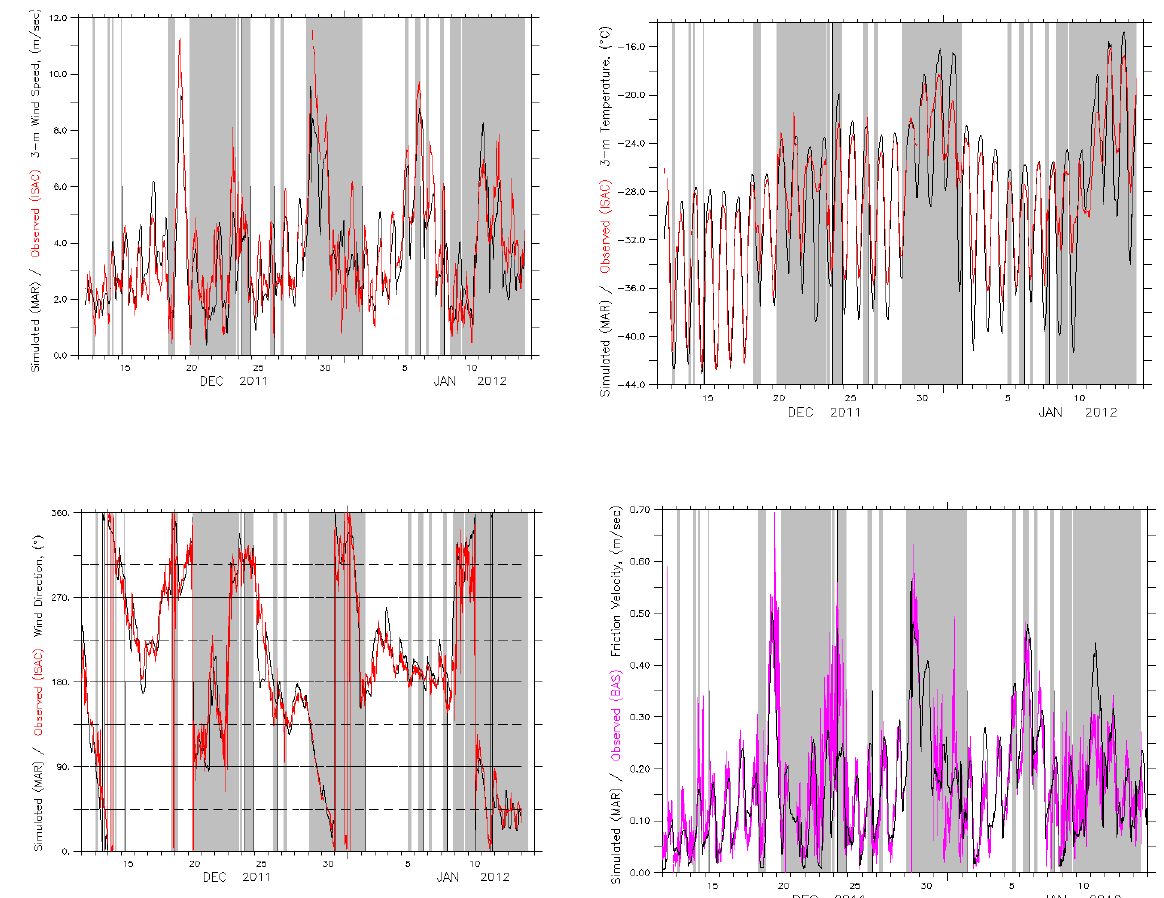
Figure 3. Simulation (dark line) of wind speed (top left), wind direction (top right), and air temperature (bottom left) at Dome C, 3m a.s.l., compared with ISAC observations. Bottom right: simulation of friction velocity (dark line) compared with BAS observations (magenta line). Data were averaged over an interval of 30min. Shaded area indicates periods with DLW > 130Wm − 2